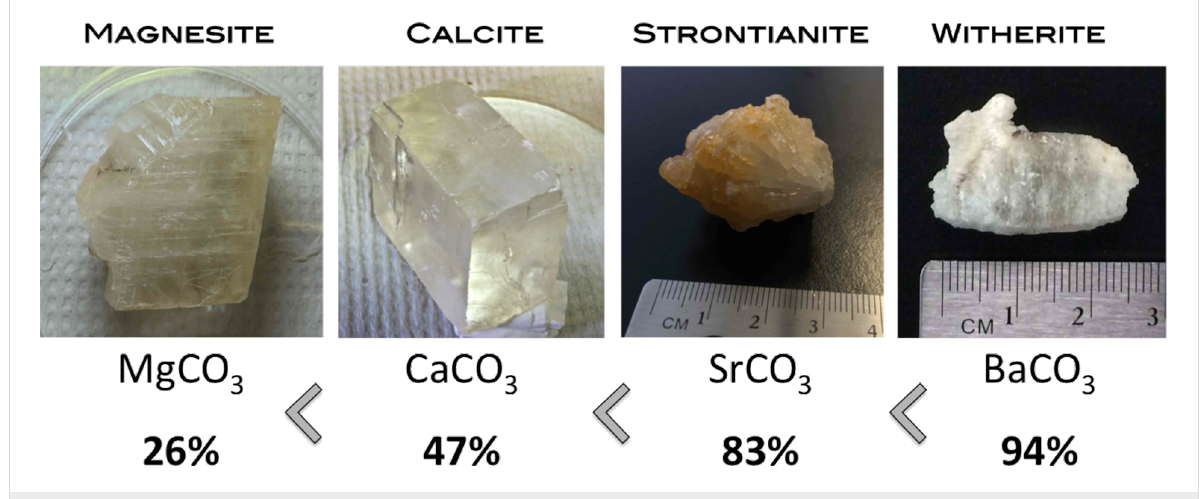
Figure 1: Adsorption of RNA on natural carbonate mineral